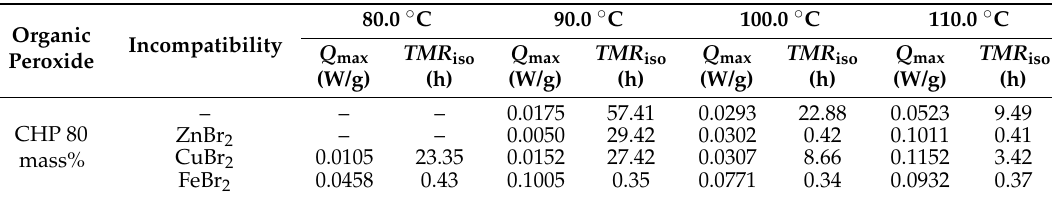
Table 3. Heat flow for 80.0 mass% CHP mixed with ZnBr 2 , CuBr 2 , and FeBr 2 , tested using thermal